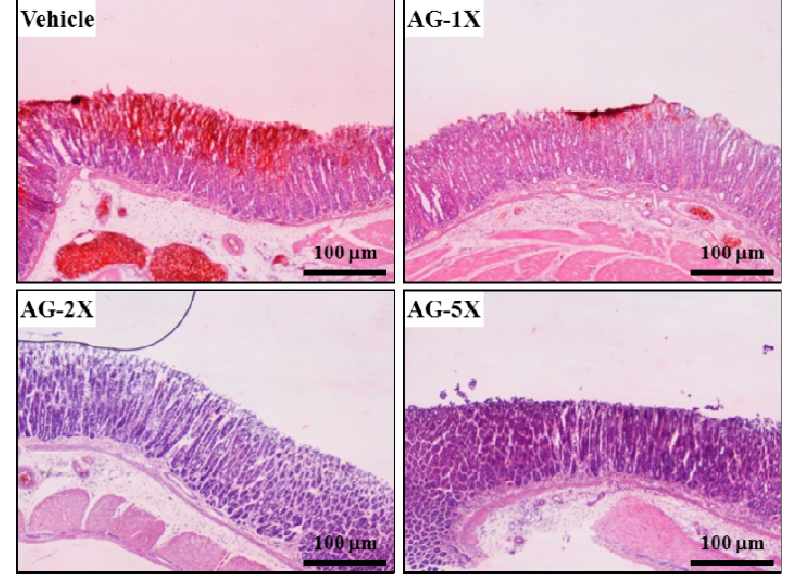
Figure 3. Histology of rat gastric mucosa with AG treatment. Rats were treated as in Figure 2. (H&E stain, magnification: ×40, Scale bar, 100 μ